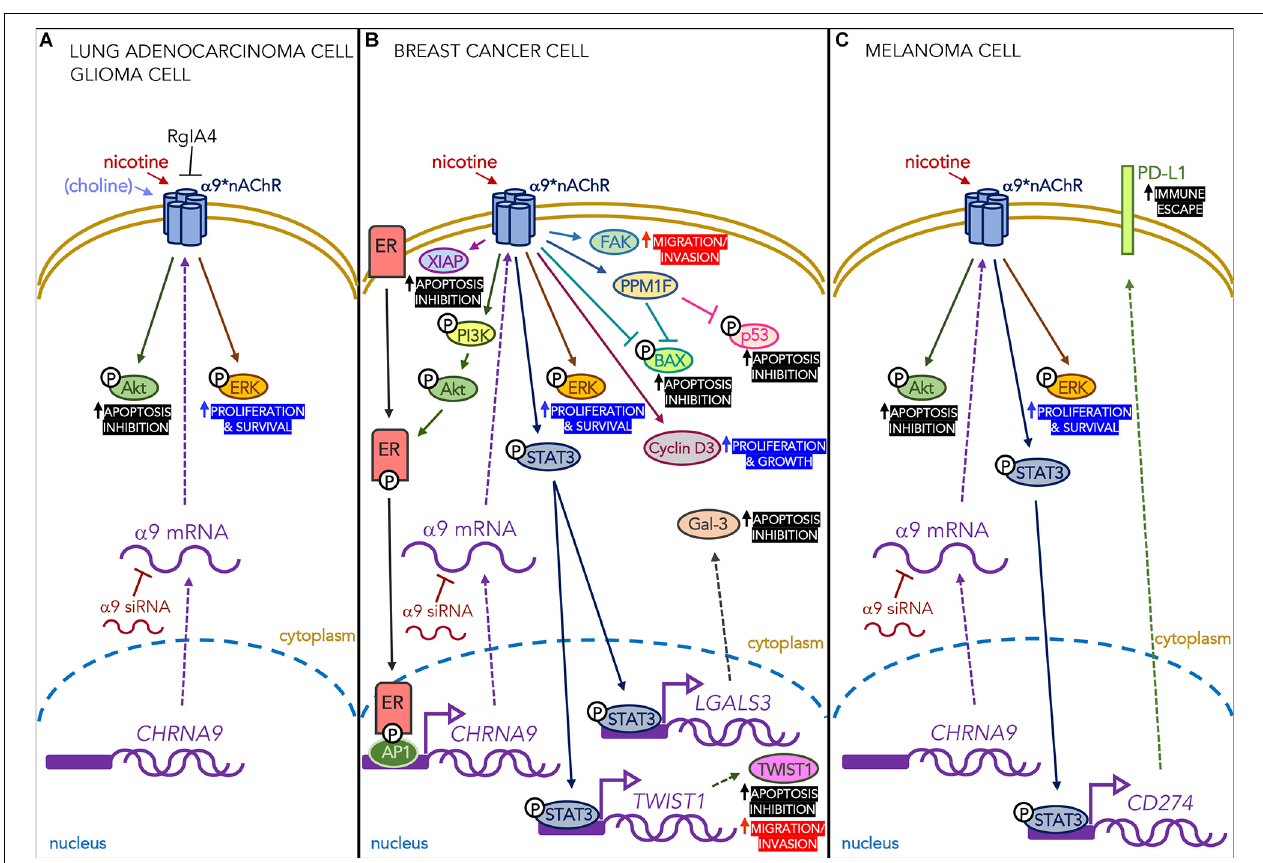
FIGURE 1 | Effects of nicotine acting on α 9-containing receptors expressed in different types of cancer cells. (A) Nicotine (in lung adenocarcinoma and glioma cells) and choline (only in glioma cells) mediate proliferative and anti-apoptotic effects through the ERK and Akt signaling pathways. These effects are blocked by the α 9-selective antagonist RgIA4 and α 9 siRNA. (B) In breast cancer cells, nicotine acting on α 9 nAChRs activates the PI3K/Akt pathway that phosphorylates intra-cellular estrogen receptors (ERs) which, in their turn, bind transcription factor AP1 and the CHRNA9 gene promoter region. It also increases the levels of pro-proliferative cyclin D3, the anti-apoptotic protein XIAP, and the PPM1F protein phosphatase that reduces phosphorylated p53 and BAX, thus protecting the cells from apoptosis. Finally, it promotes the phosphorylation of STAT3 and its nuclear translocation, thus increasing the transcription of the gene encoding the anti-apoptotic lectin Gal-3. All of these effects are blocked by α 9 siRNA. (C) In melanoma cells, nicotine increases the number of α 9 nAChRs and phosphorylates STAT3, which binds the PD-L1 promoter in the nucleus and leads to the higher surface expression of PD-L1, thus promoting the immune escape of cancer cells. The increased expression of PD-L1 protein is down-regulated by α 9